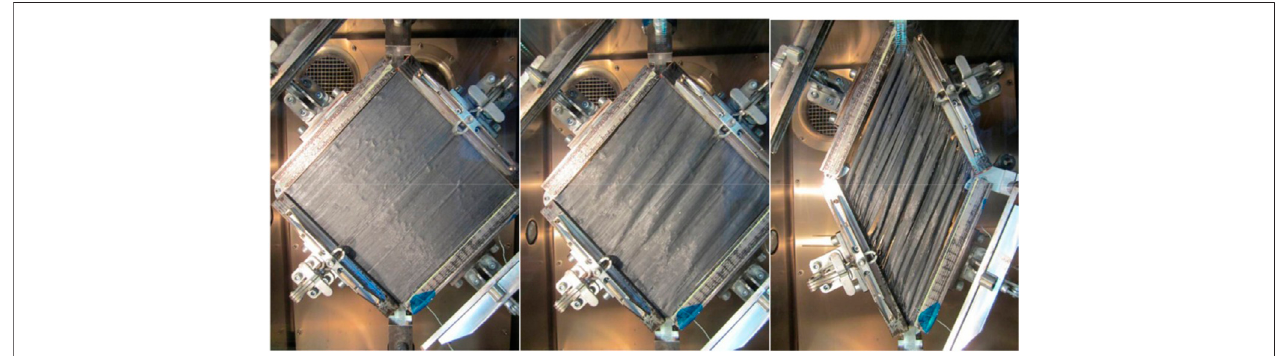
FIGURE4| Anexampleofin-plane shearcharacterization ofpre-impregnatedUDcarbon/epoxy:picture-frametest ona4-ply stackofUDofsameorientation (left to right: initial con fi guration, intermediate shear angle of 2 ° , fi nal shear angle of 40 ° ) (Leutz,